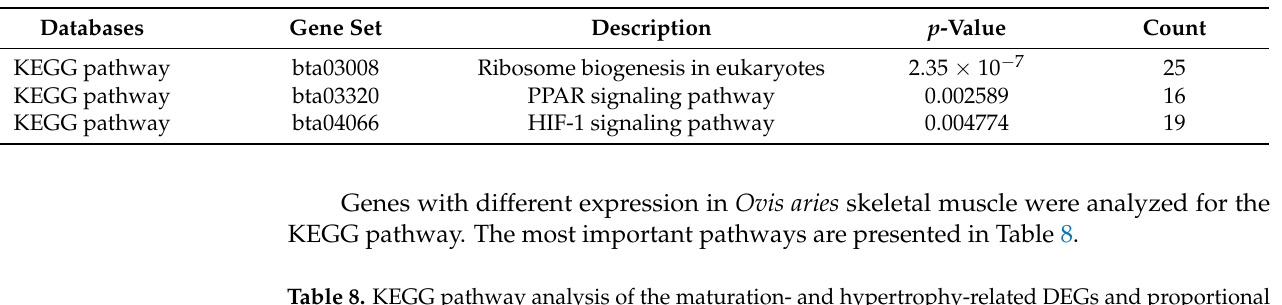
Table 8. KEGG pathway analysis of the maturation- and hypertrophy-related DEGs and proportional p -values identified in Ovis aries .